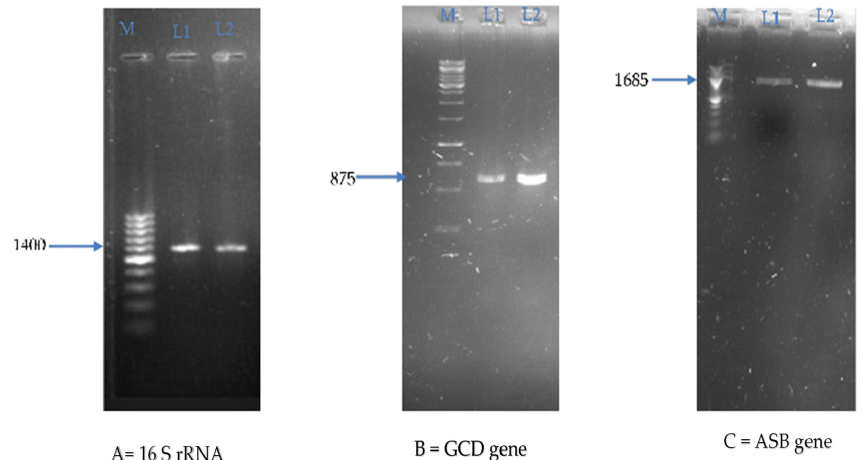
Figure 1. Endophytic bacterial strains S. geniculata NWUBe21 and P. carnis NWUBe30; amplified genes for 16S rRNA; the glucose dehydrogenase gene (Gcd), and the petrobactin siderophore biosynthetic gene (Asb). M = 1kb ladder; L1 = S. geniculata NWUBe21; L2 = P. carnis NWUBe30.